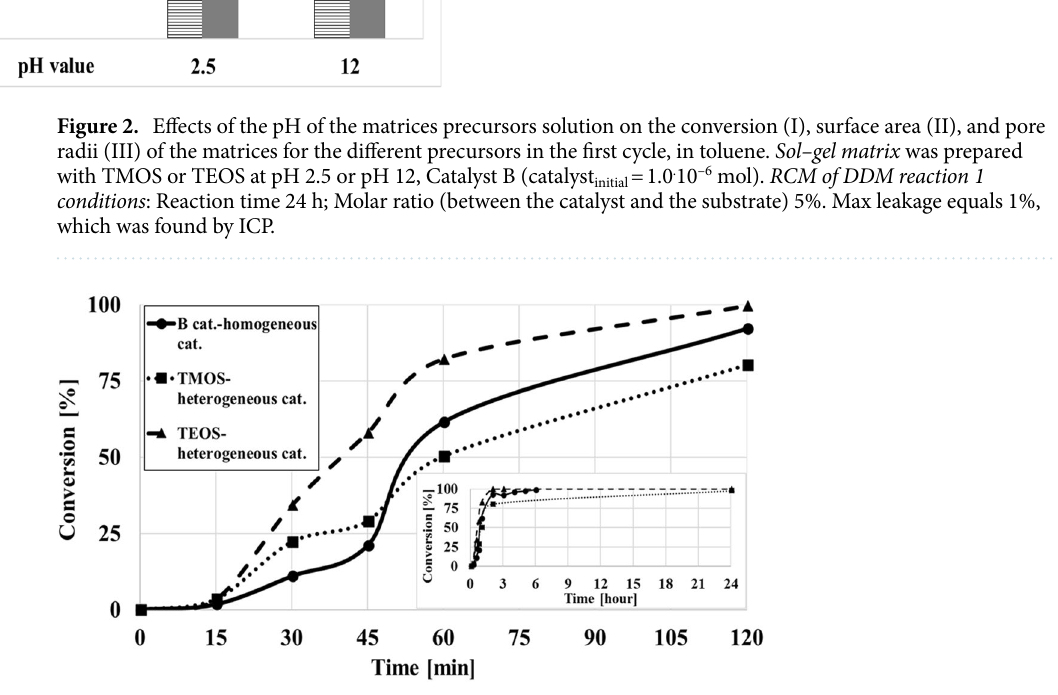
Figure 3. Conversion percentages in toluene as a function of time. Sol–gel matrix was prepared with TMOS or TEOS at pH 12, Catalyst B (catalyst initial = 1.0 . 10 –6 mol). RCM of DDM reaction 1 conditions: Molar ratio (between the catalyst and the substrate) 5%; Reaction time: 0–120 min. Figure insert: the same conditions as in Fig. 4, reaction time 0–24